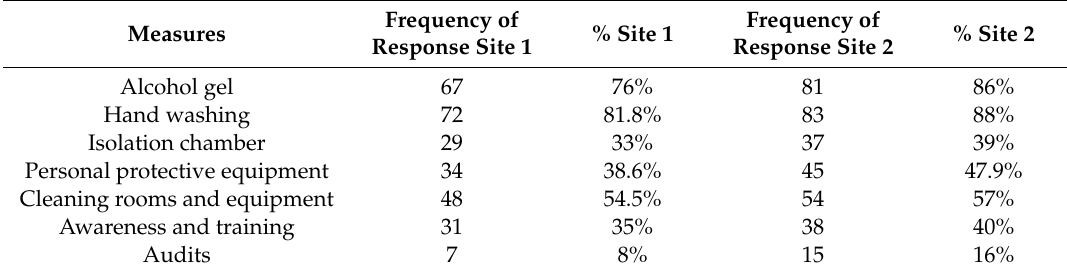
Table 5. Comparison of strategies reported by sta ff being undertaken at the sites for infection